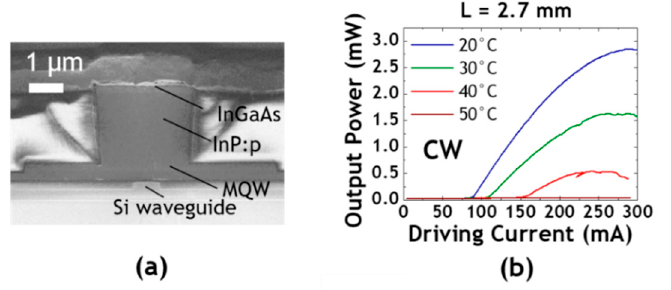
Figure 13. ( a ) Cross-section of the FP laser observed by SEM; ( b ) light-current characteristics measured under CW operation up to 50 °C.